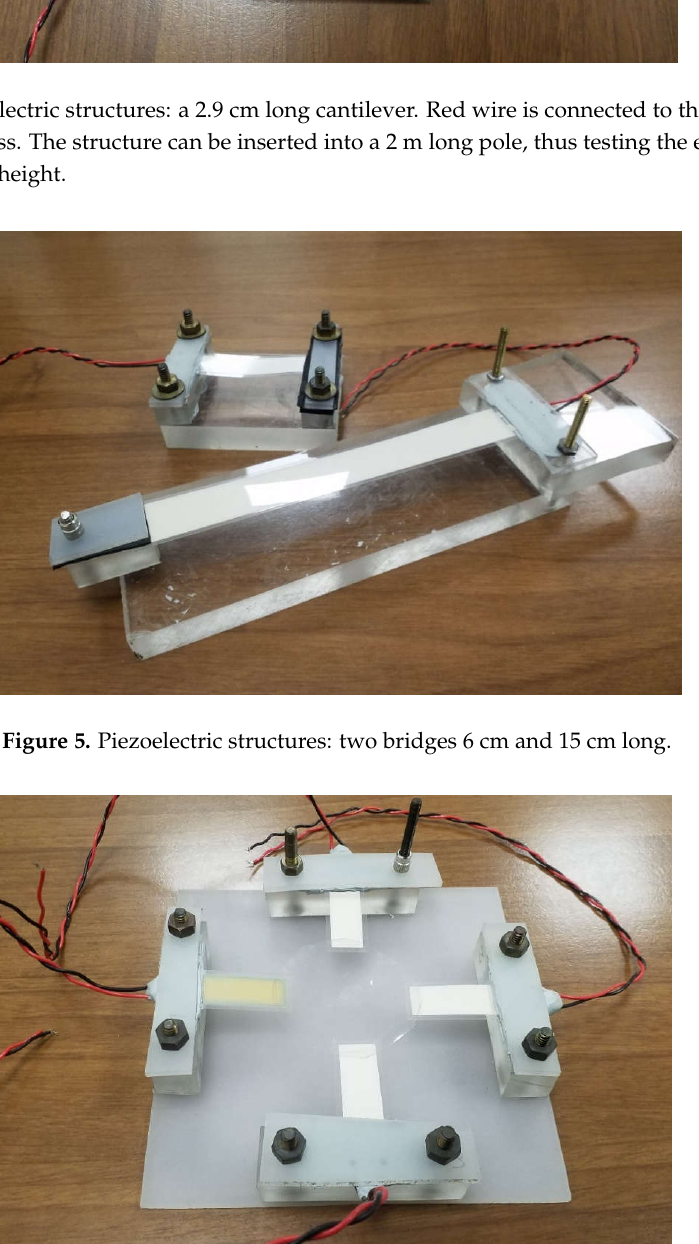
Figure 6. Piezoelectric structures: a floating circle, held up by 4 × 2.5-cm-long piezoelectric structures.